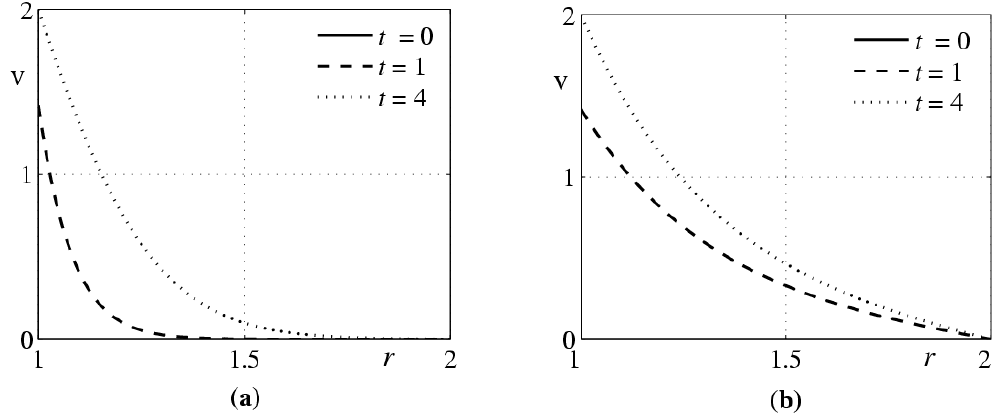
and v 0 ( r ) = 0, ν = 10 − 2 cm 2 /s, ω = 2 s − 1 .